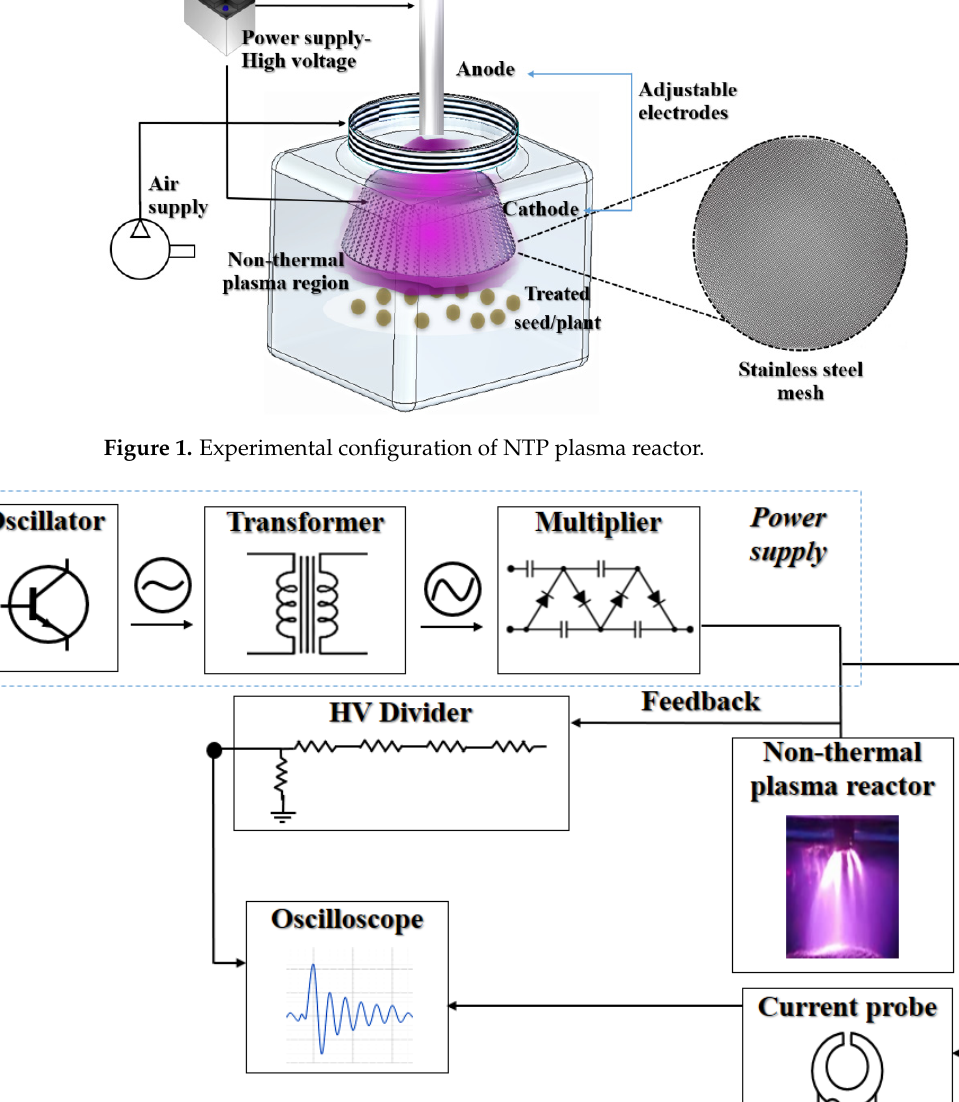
Figure 1. Experimental configuration of NTP plasma reactor .